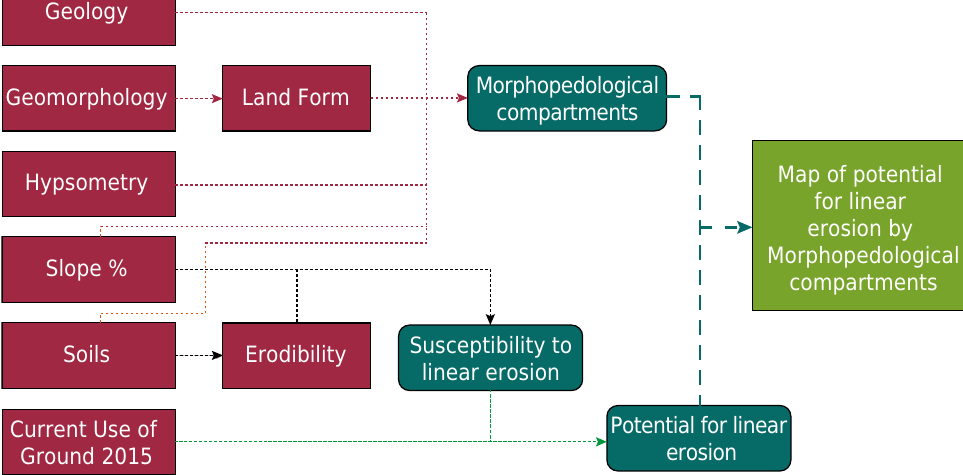
Figure 3. Flowchart of the cartographic procedures adopted to generate the map of linear erosion potential of the municipality of São Miguel do Araguaia, state of Goiás,